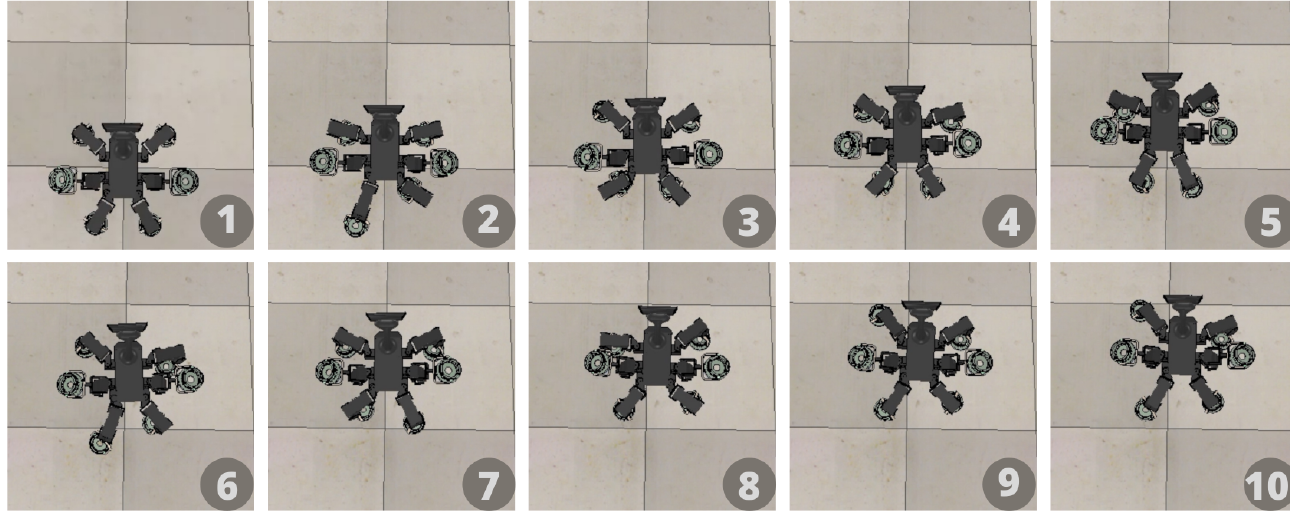
Figure 8. Motion sequences during a walking pattern. The two center legs are disabled, pointing the suction cup